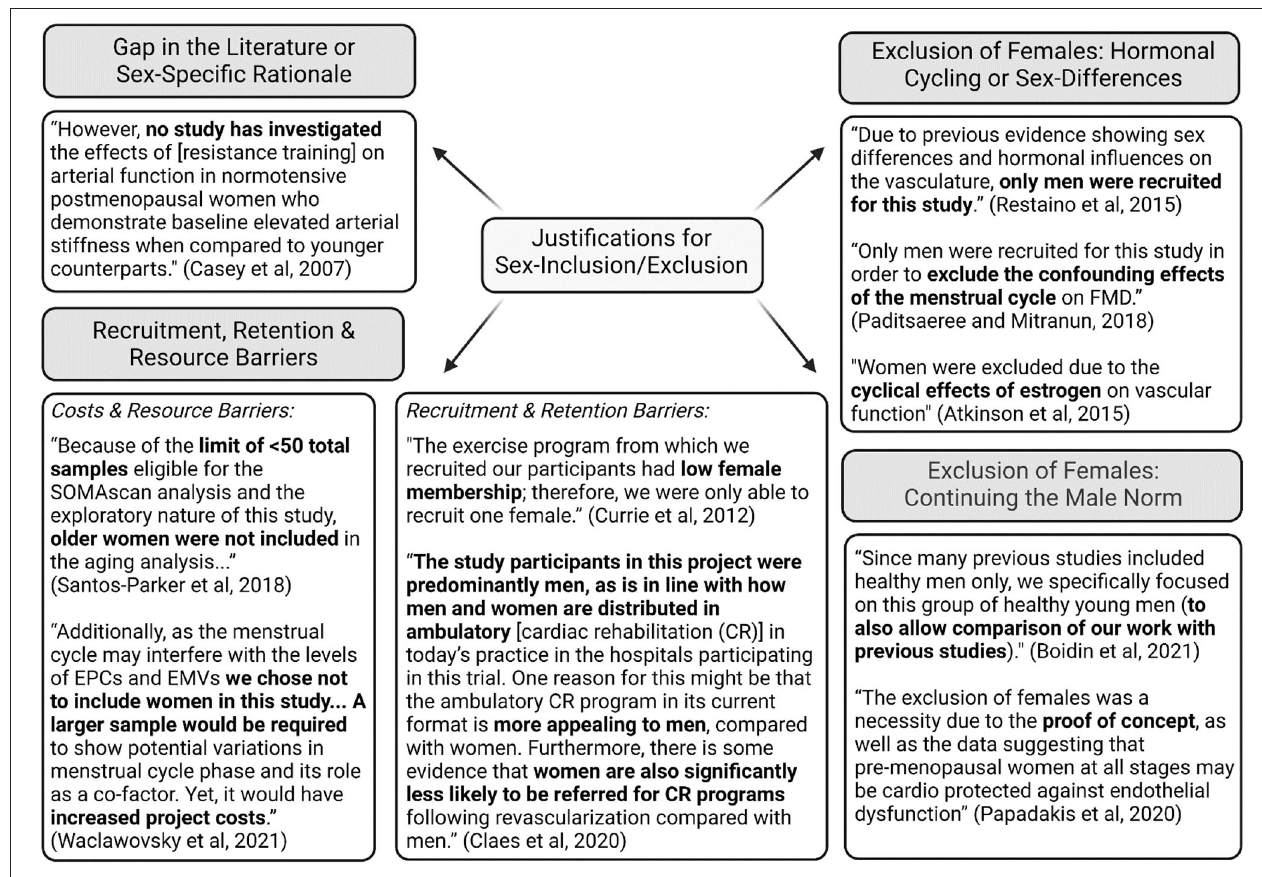
FIGURE 4 | Summary of qualitative themes for sex-inclusion/exclusion and representative quotes.